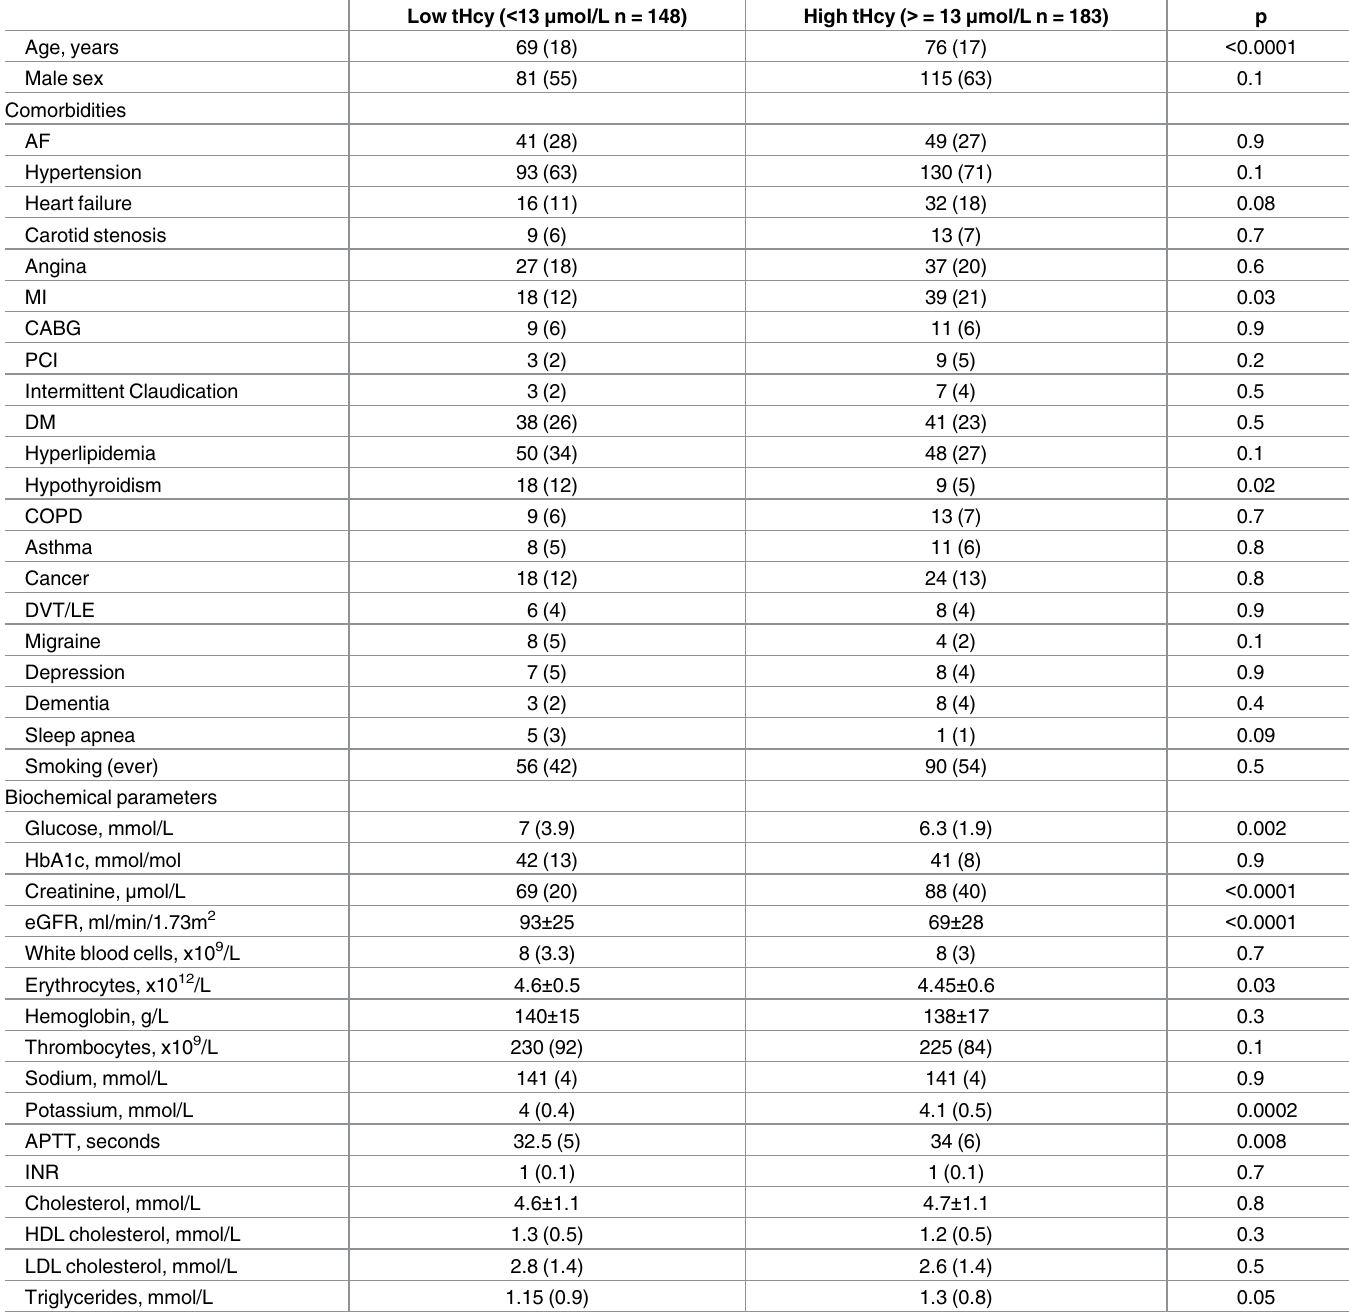
Table 1. Baseline characteristics of study participants according to plasma homocysteine